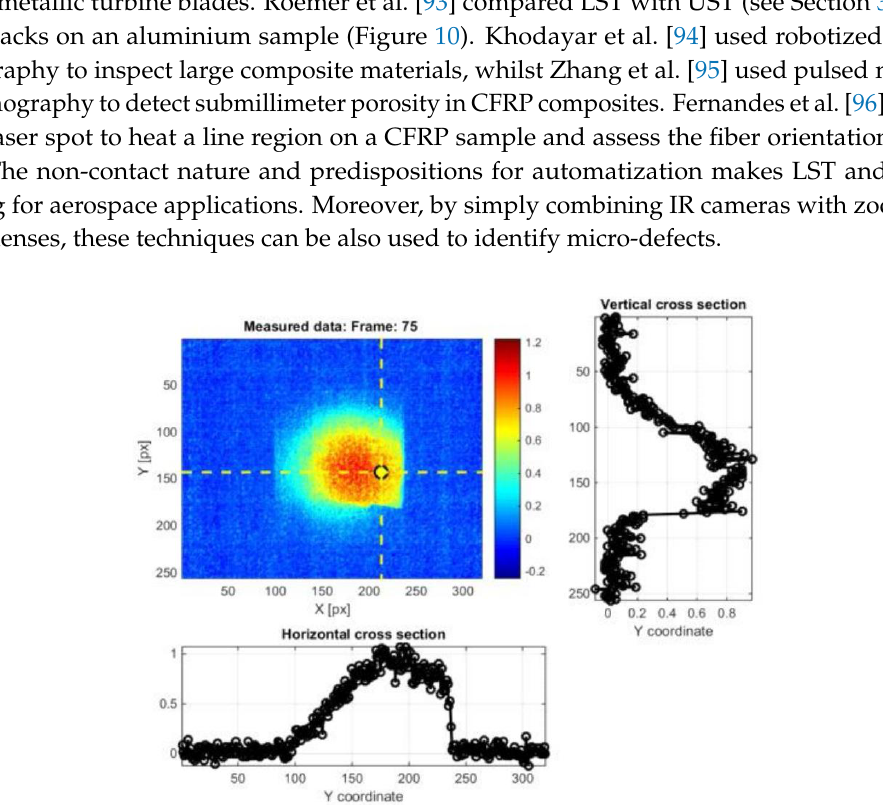
Figure 11. Experimental set-up of ultrasonic stimulated thermography, from 97 .